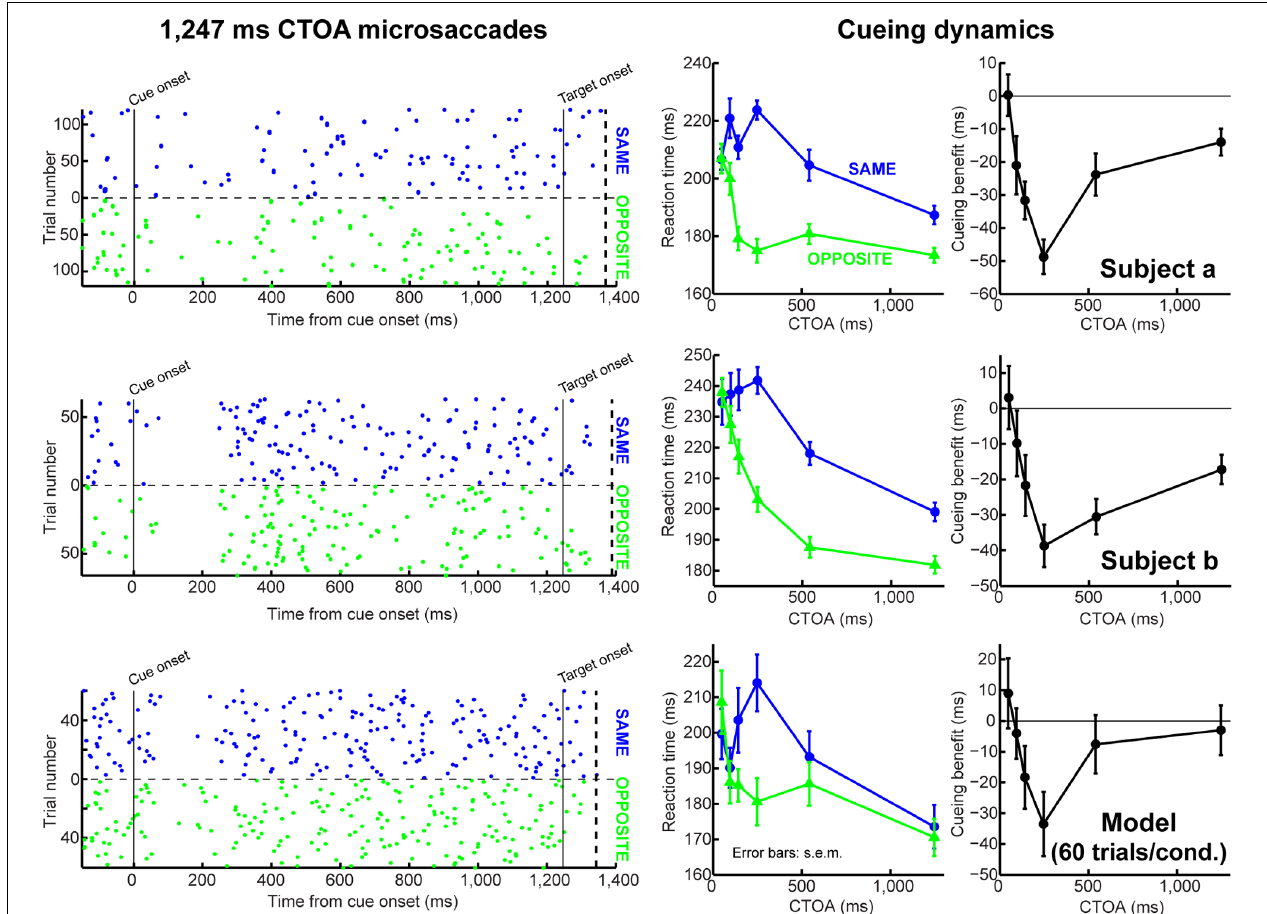
FIGURE 7 | Accounting for behavioral dynamics even with few microsaccades. In this figure, we show data from individual subjects (first two rows) and from the model when it was run with a small number of trials (third row). The first column shows microsaccade onset times (as dot rasters) for 1,247 ms CTOA’s. Each dot indicates a microsaccade onset, and each row corresponds to a single trial. The trials were sorted according to the target being at the same (blue) or opposite (green) location as the cue. The right two columns show behavioral dynamics. In the third row, we ran the model with only 60 trials per condition, which is the smallest number of repetitions that we got from one of our subjects. Thus, even when simulated as an individual subject, the model could replicate behavioral dynamics. Importantly, microsaccades did not happen particularly frequently in this simulation (dot rasters), but this was still sufficient to generate realistic dynamics (right two columns). The dashed vertical line in the left column graphs indicates the earliest RT observed for each subject/model. Also, note that different individual subjects had different intrinsic microsaccade frequencies (compare dot rasters from subjects a and b). Figure 8 demonstrates how our model can also simulate such inter-subject variability. All error bars denote